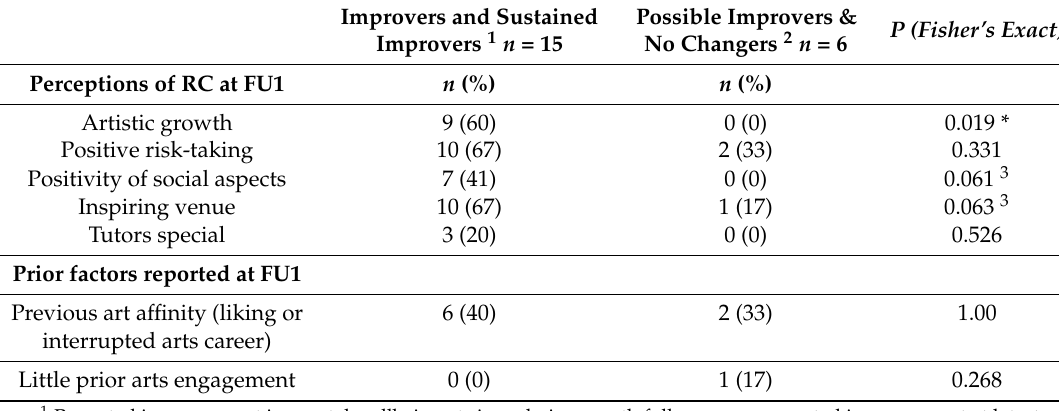
Table 11. Variables (as self-reported) associated with more and less self-reported improvement in mental